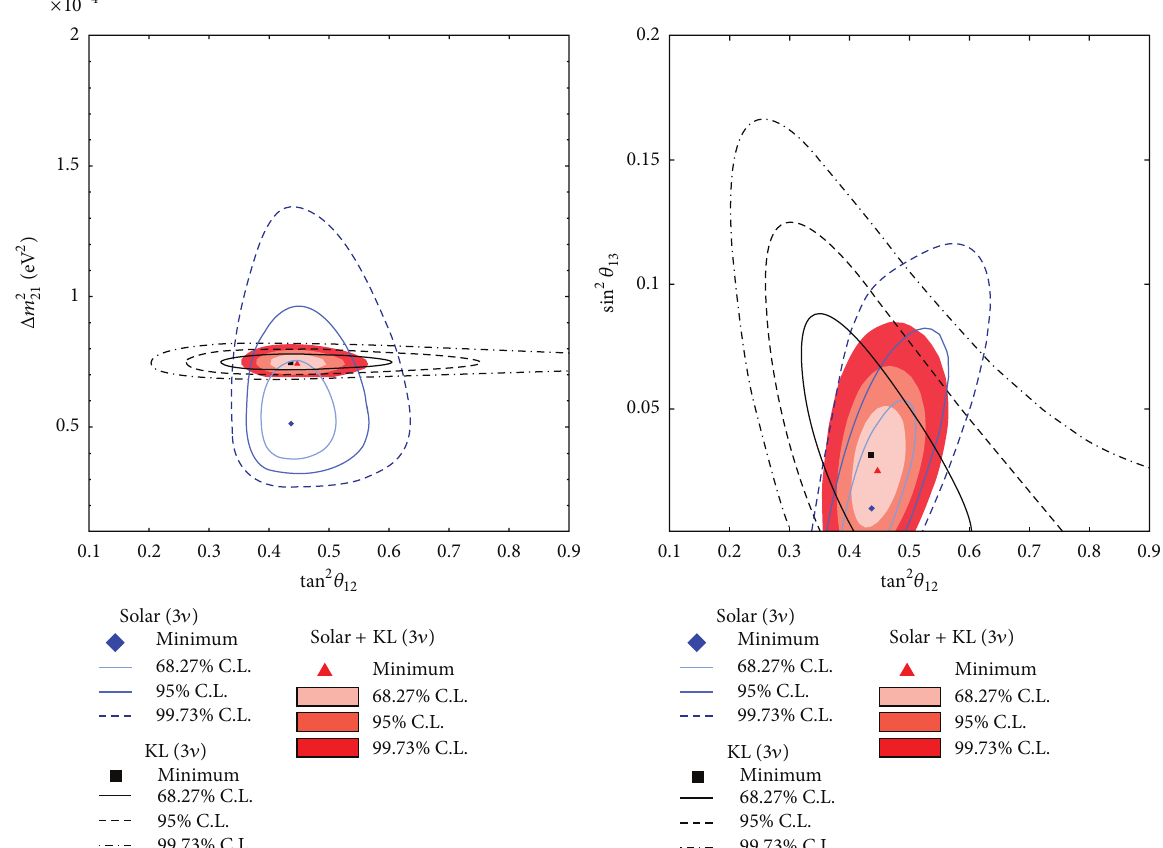
Figure 14: Three-flavor neutrino oscillation analysis contour using both solar neutrino and KamLAND results. Taken from [147].